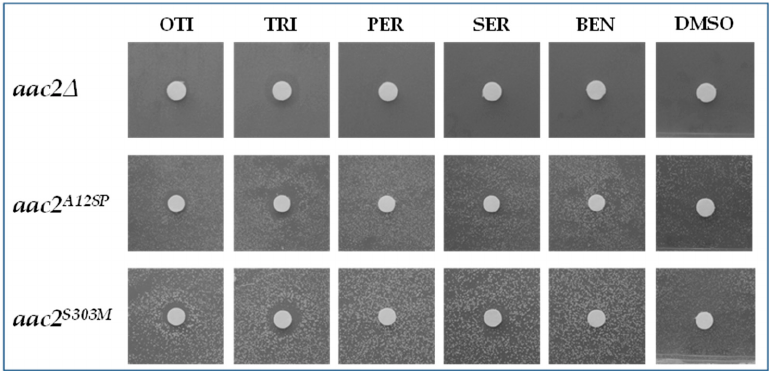
Figure 3. Effect of active compounds on the null aac2 ∆ mutant and on the WB-12 strain transformed with aac2 A128P and aac2 S303M mutant alleles. Each filter was spotted with 2.5 μ L of the drugs at the following concentrations: OTI = otilonium bromide 2 mM; TRI = trifluoperazine 2HCl 5 mM; PER = pergolide mesylate 25 mM; SER = sertraline HCl 5 mM; BEN = benzydamine HCl 25 mM. DMSO, the compound vehicle, was used as a negative control.